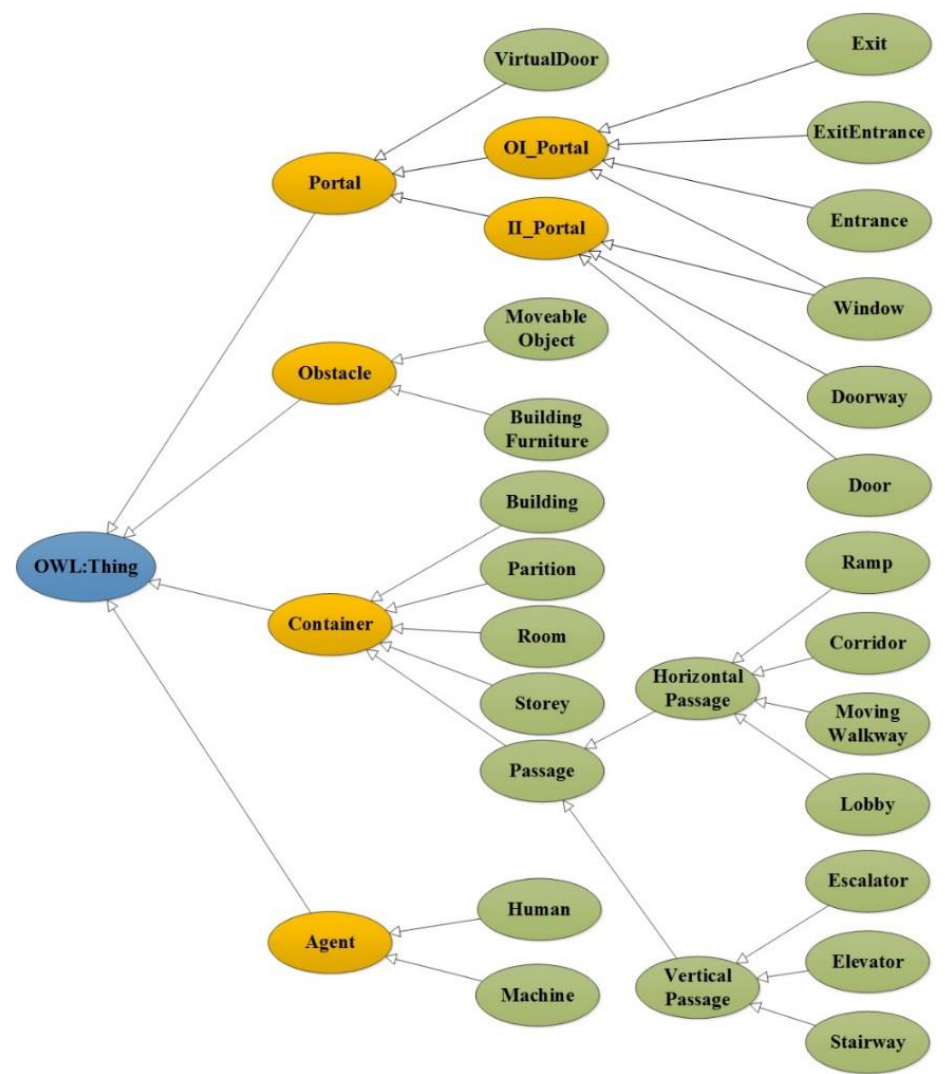
Figure 2. Ontology Concepts of Indoor